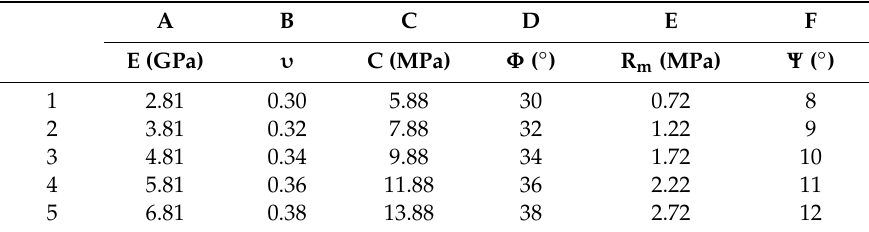
Table 3. Research level of orthogonal numerical simulation experimental parameters.